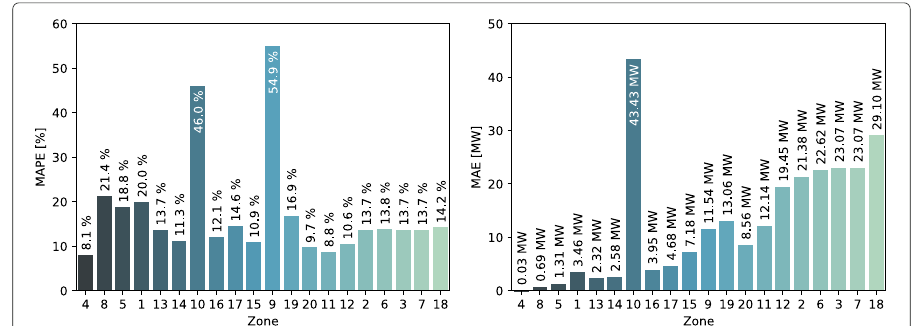
Fig. 3 MAPE (left) and MAE (right) of Hong’s benchmark model for different zones (ordered by average